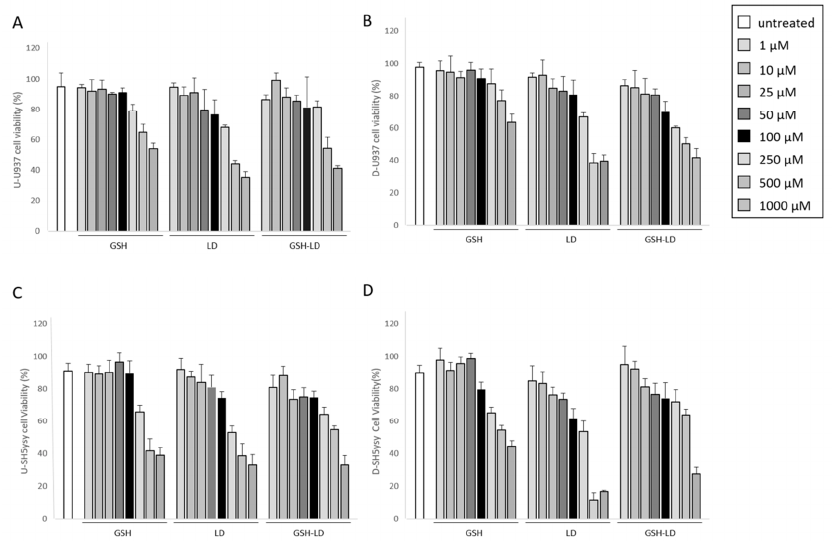
Figure 2. E ff ect of compounds on cell viability. The MTT (3-(4,5-Dimethyl-2-thiazolyl)-2,5-diphenyl- 2H-tetrazolium bromide) cell viability of GSH, LD and GSH-LD (1, 10, 50, 100, 250, 500 and 1000 µ M), on ( A ) undi ff erentiated U937 (U U937 ) cells; ( B ) di ff erentiated U937 (D U937 ) cells; ( C ) undi ff erentiated SH-SY5Y (U SH-SY5Y ) and ( D ) di ff erentiated SH-SY5Y (D SH-SY5Y ) using an incubation time of 24